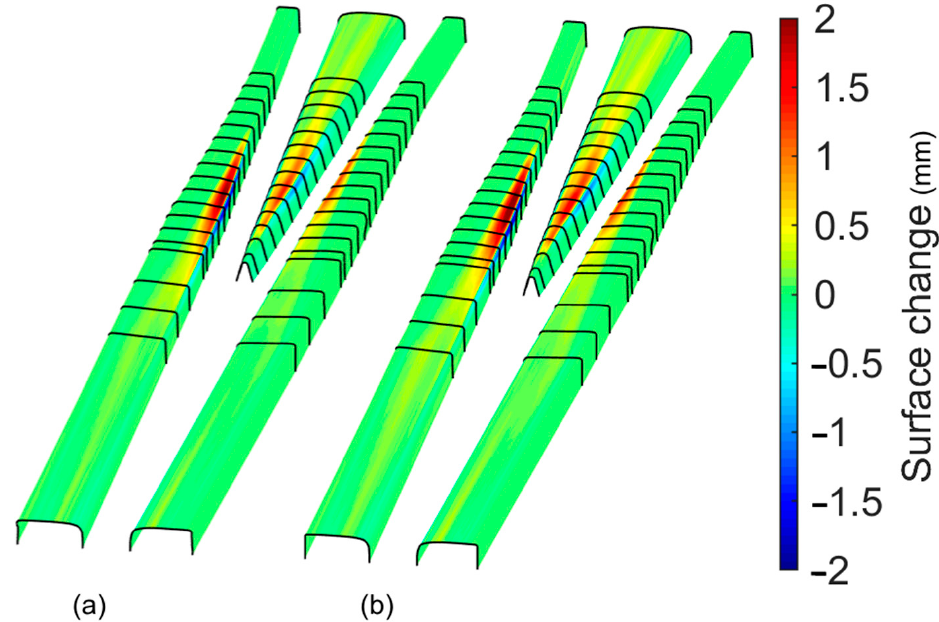
Figure 9. Measured deformation of a crossing nose after ( a ) 11.9 MGT and ( b ) 19.2 MGT of mixed traffic. The surface change corresponds to the difference between the surface geometries of the worn and new crossings.